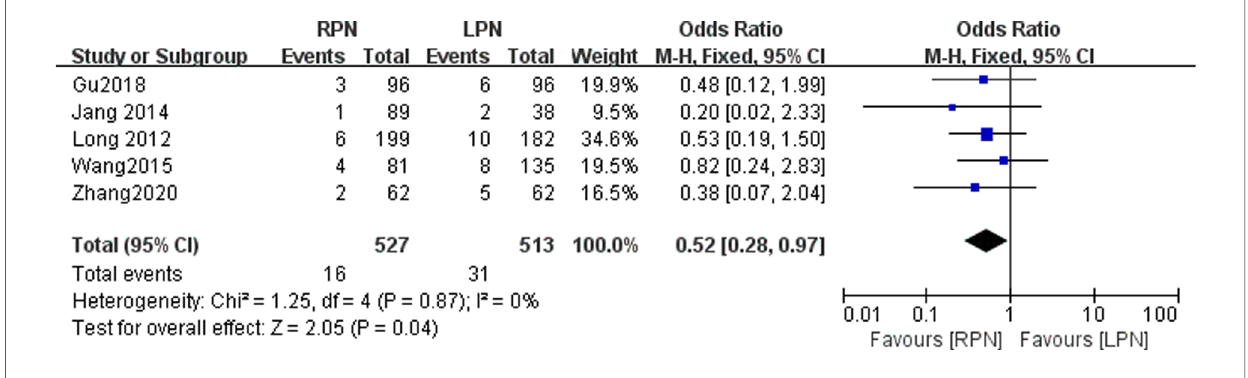
FIGURE 8 Forest plot for intraoperative complications between the RPN and LPN.